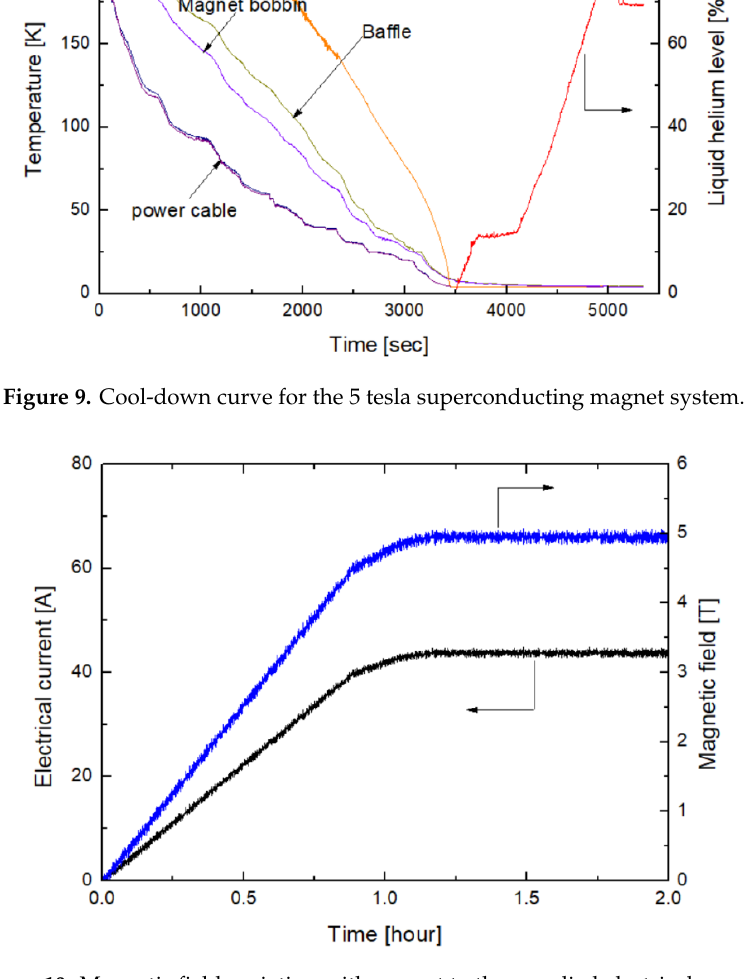
Figure 9. Cool-down curve for the 5 tesla superconducting magnet system.